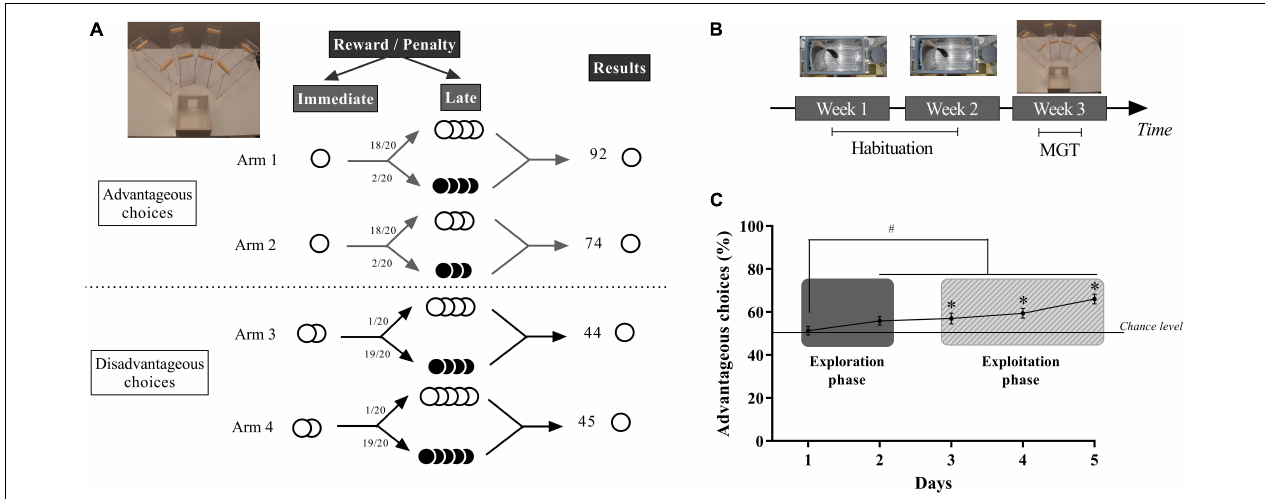
FIGURE 1 | (A) Schematic representation of the MGT experimental design that takes place in a four-arm maze. In advantageous arms, mice find one pellet (small immediate reward) before a bottle cap containing three or four food pellets in 18 of the 20 trials and the same number of quinine pellets for the two remaining trials. In the disadvantageous arms, mice find two food pellets (large immediate reward) before a bottle cap containing four or five quinine pellets in 19 of the 20 trials and the same number of food pellets in the remaining trial. (B) Timing of the decision-making test: 2 weeks of operant chambers followed by 1 week of MGT. (C) Schematic representation of the mean of the percentage of advantageous choices of mice during 5 days of the MGT with illustrations of the exploration phase and the exploitation phase. ∗ p < 0.05 from the chance level, # p < 0.05 differences between session 1 and the other sessions. Adapted from Pittaras E. et al. (2016) and Pittaras et al. (2018,